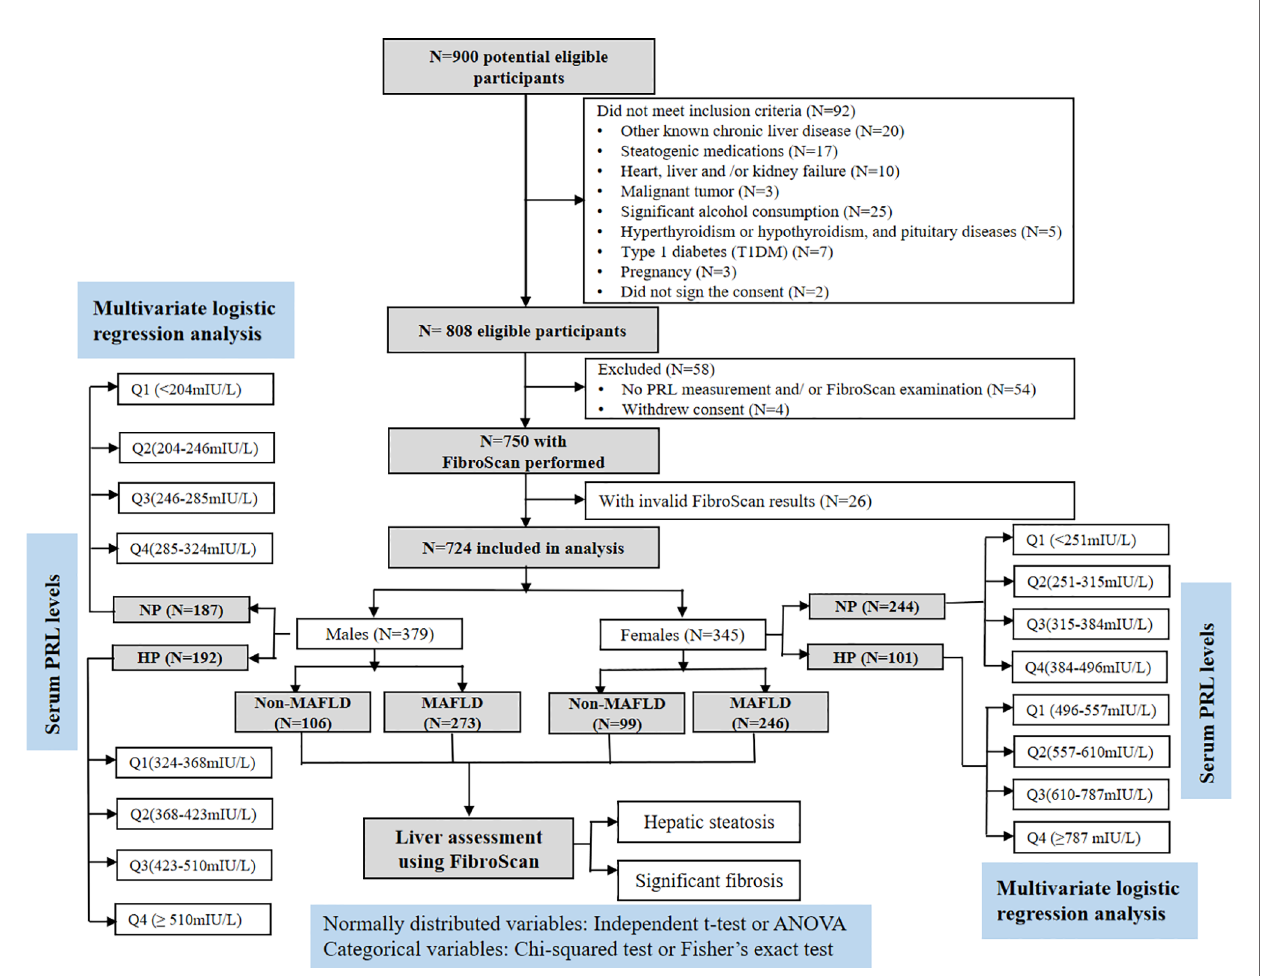
FIGURE 1 | Flowchart of the study enrollment. Of the 900 selected patients, those who did not meet the inclusion criteria ( n = 146) or decide to withdraw from the study ( n = 4) were excluded. Another 26 patients with invalid FibroScan results were also excluded. As a result, 724 patients were included in the fi nal